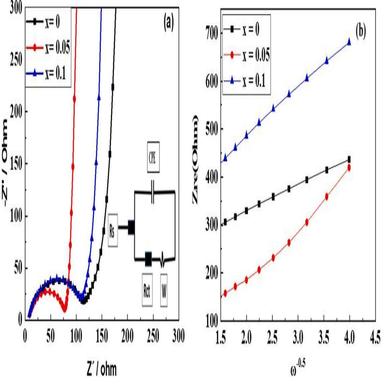
(a) EIS curves of LZTNO materials (b) Graph of Zre plotted against ω 1/2 at low-frequency region.